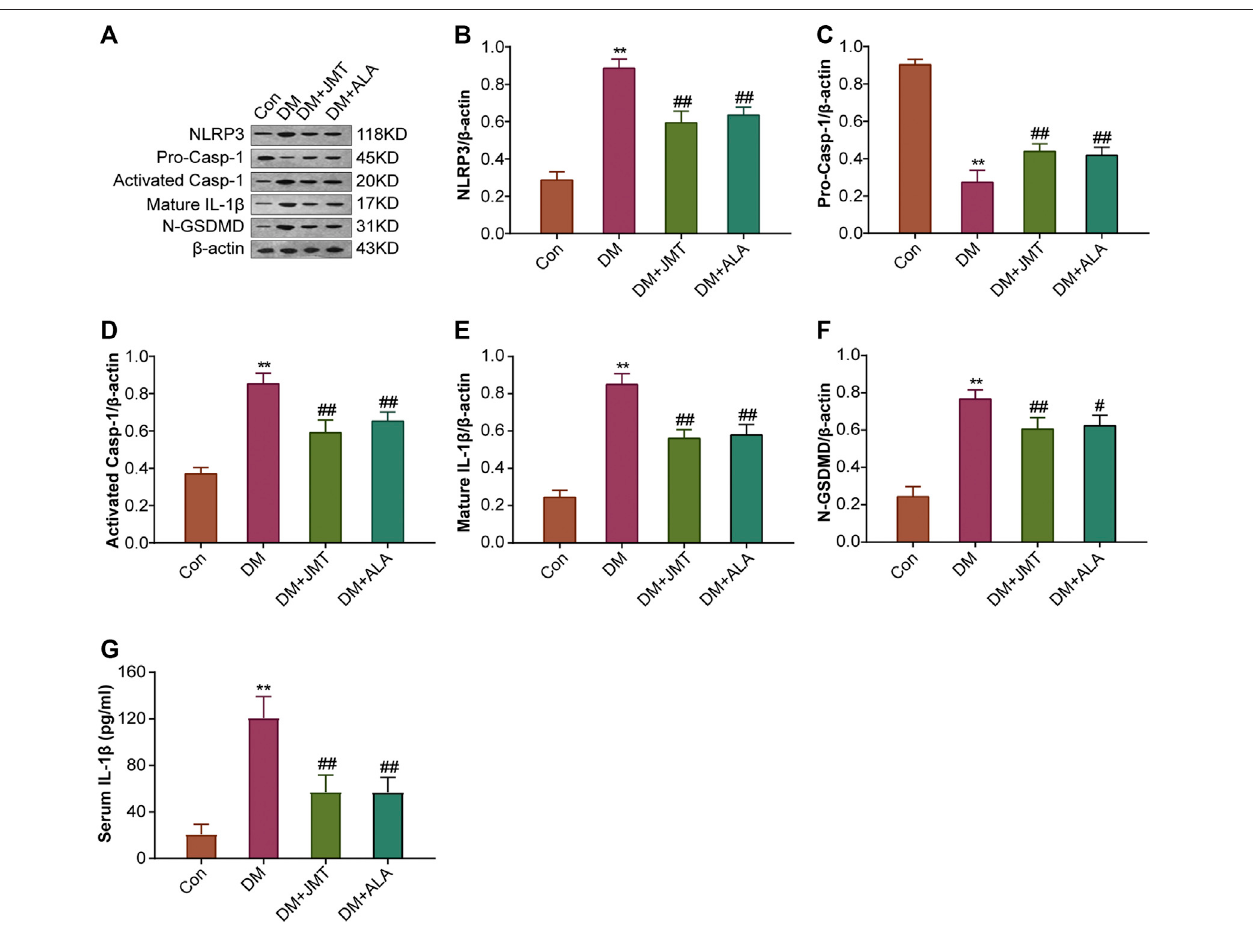
FIGURE 5 | Effects of JMT on the protein expressions of NLRP3 in fl ammasome components and GSDMD in DRG of diabetic rats (A) Representative western blot imagesofNLRP3,pro-caspase-1,activated-caspase-1,IL-1 β andGSDMDinDRGafter12weeks.Quantitativeanalysisof (B) NLRP3 (C) pro-caspase-1 (D) activated- caspase-1 (E) IL-1 β and (F) GSDMD protein expressions normalized to β -actin. The data are presented as mean ± SEM (n (cid:1) 3 per group) (G) Serum IL-1 β levels were analyzedusingELISA(n (cid:1) 6pergroup).** p < 0.01 vs Congroup, # p < 0.05 vs DMgroup, ## p < 0.01 vs DMgroup.Con,control;DM,diabetesmellitus; ALA,alpha- lipoic